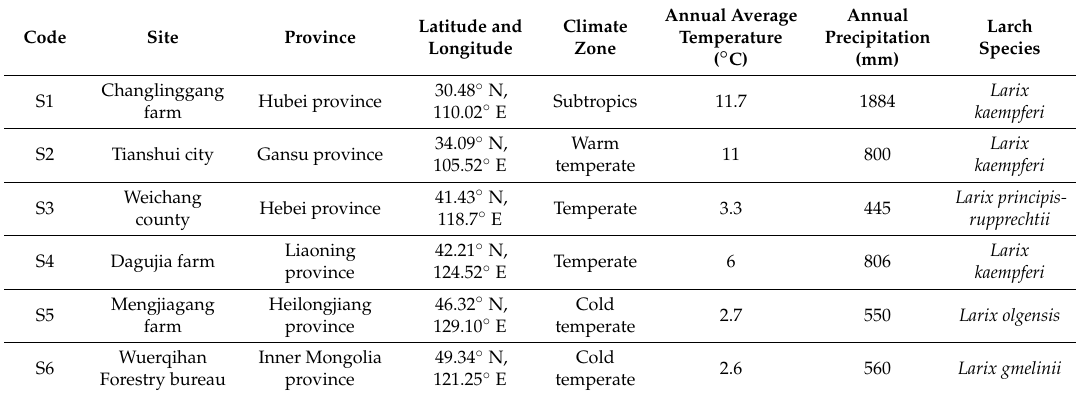
Table 1. The code and basic featuresof study